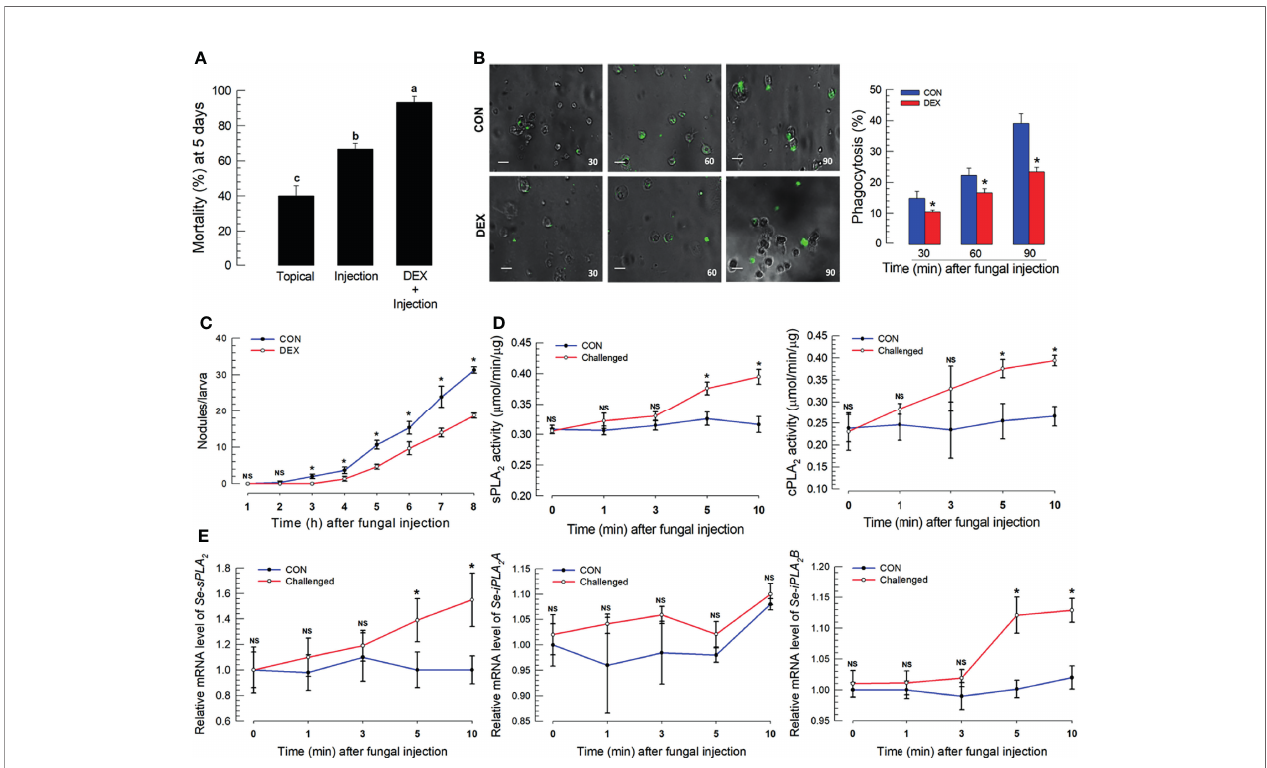
FIGURE 1 | S. exigua immuneresponses to a M. rileyi fungal infection.For allpanels, control ( ‘ CON ’ ) represents solvent (DMSO)injection.Panel (A) shows the in fl uence of fungal topical application or injection (1,000 conidiaper L5larva) on mortality at5 DPF. Co-injectionsof DEX (10 m g/larva)+conidialed to increased mortality. Each treatment was replicatedthree times with 10 larvae per replication.Panel (B) reports the in fl uence of DEX on phagocytosis, determined by fl uorescence emitted from internalized FITC- labeled conidia. The assayswere replicated at the indicated time points with biologicallyindependent samples. Scalebar represents 10 m m.The accompanying histogram shows proportionsof phagocytichemocytes at the indicated times. Panel (C) shows mean nodules/larvae at the indicated times PFI. L5larvae were injectedwith 2 µL of conidia (1×10 5 conidia/mL). The number of nodules were countedin three larvae at each timepoint. Panel (D) shows sPLA 2 activities in plasma and cPLA 2 activities in fat bodyat theindicatedtimes PFI (n= 3 biologically independent replicates with 10 larvae/replicate).Panel (E) exhibits relative accumulationsofmRNAs encodingthe indicated PLA 2 s at 1, 3, 5, and 10 h PFI. ‘ NS ’ , nosigni fi cant difference. Data analyzed andpresented as described in Methods . Different lettersor asterisksabove standard deviation barsindicate signi fi cant differenceamongmeansat TypeI error = 0.05 (LSD